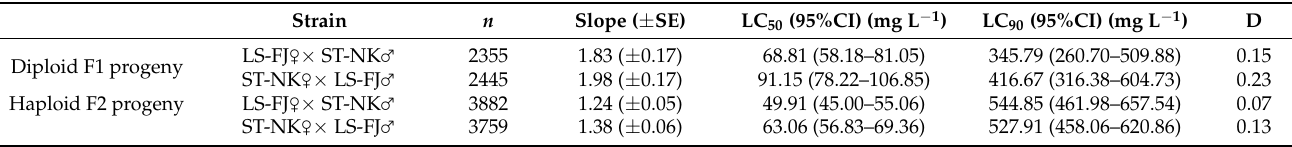
Table 2. Probit statistics of the reciprocal crosses tested against spirotetramat ( n = number of mites, D = degree of